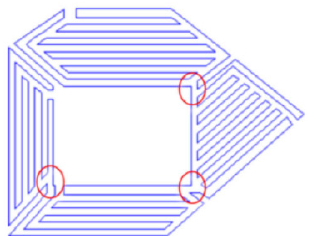
Figure 19. Convex polygonal method [105].